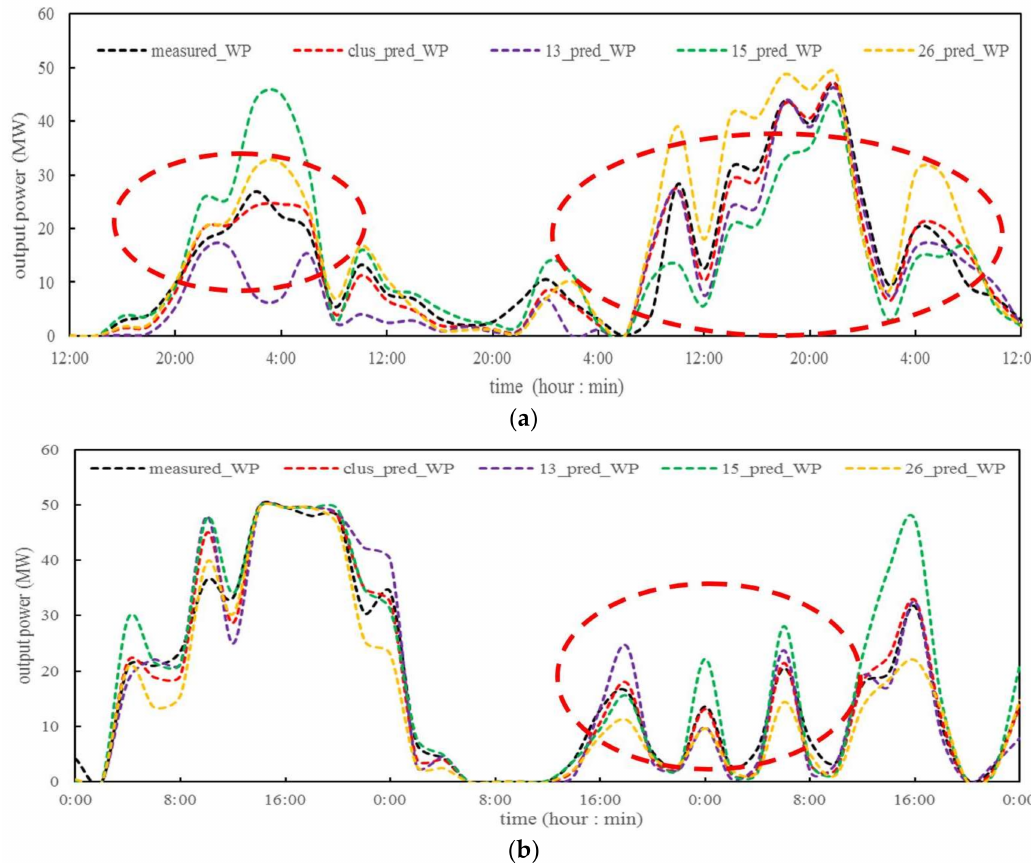
Figure 13. Short-term variations of the predicted power using different databases: ( a ) January; ( b )